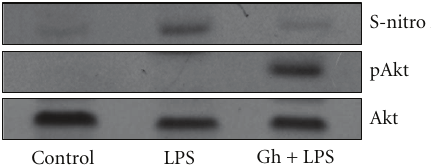
Figure 8: E ff ect of Ghrelin (Gh) on P. gingivalis LPS-induced Akt S- nitrosylation. The sublingual salivary gland cells were treated with the LPS at 100 ng/mL, or Gh at 0.6 μ g/mL + LPS and incubated for 16h. A portion of the cell lysates was processed by biotin switch procedure for protein S-nitrosylation and, along with the reminder of the lysates, subjected to SDS-PAGE, transferred to nitrocellulose, and probed with phospho-Akt (Ser 473 ) antibody, and after stripping reprobed with anti-Akt antibody. The immunoblots shown are representative of three